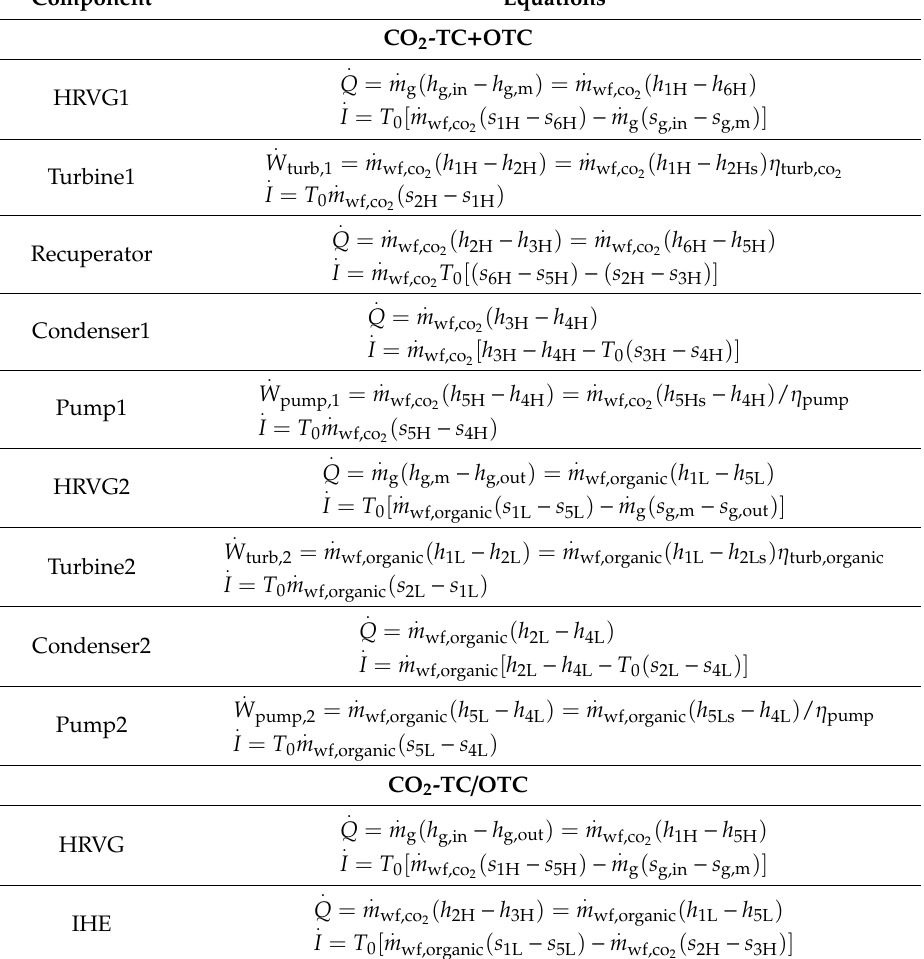
Table 1. Thermodynamic models in each component of the two combined cycles.